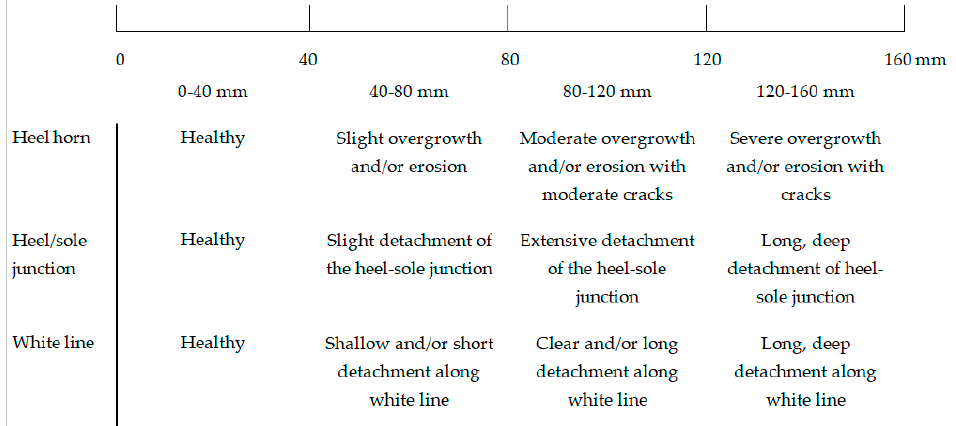
Table 1. Specifications of the Mobile Claw Scoring Device (MCSD).